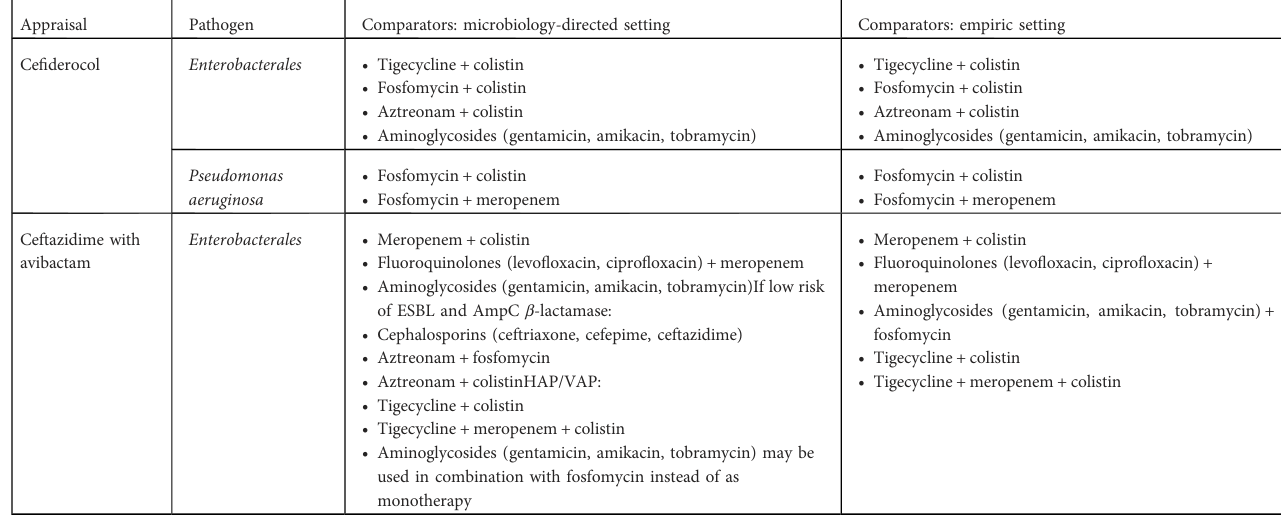
TABLE 1 Comparators in the HTAs of ce fi derocol, and ceftazidime with avibactam. Appraisal